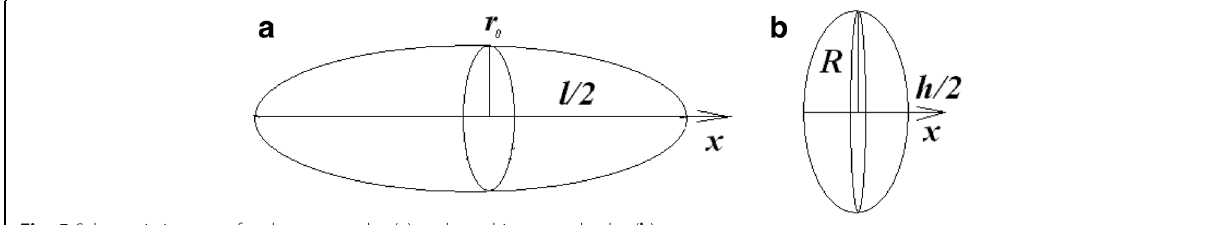
Fig. 5 Schematic images of carbon nanotube ( a ) and graphite nanoplatelet ( b